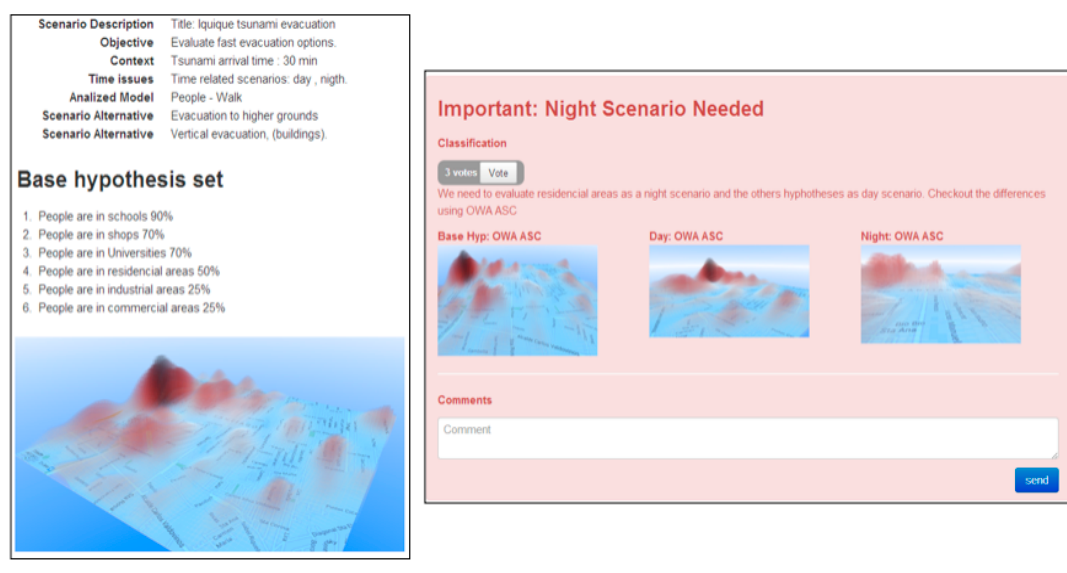
Figure 3. Left: Scenario description and suitability map. Right: Collaborative discussion area.